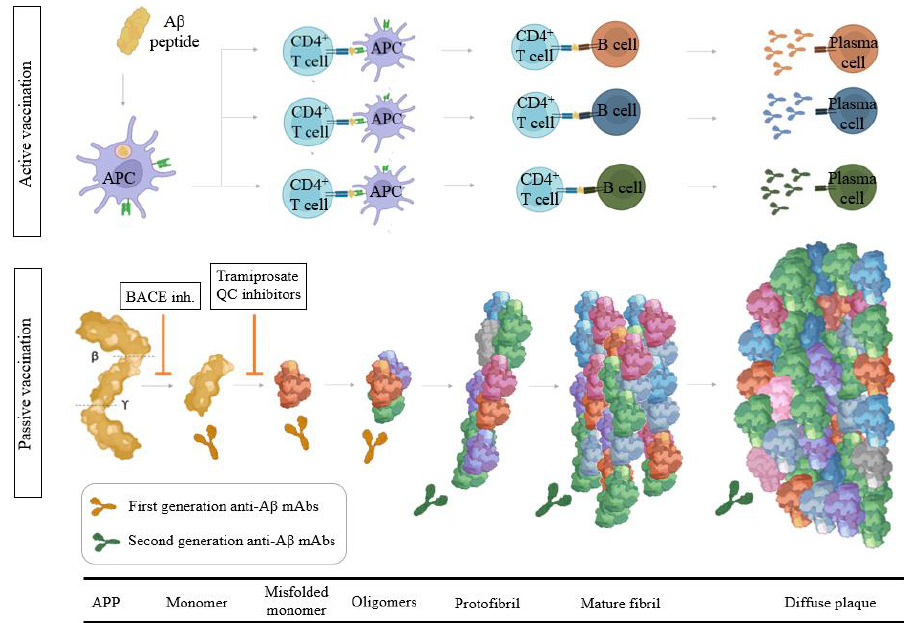
Figure 1. Anti- Aβ protei n strategies for the development of DMT. Both active and passive immu- notherapy are currently under evaluation for reducing amyloid deposition and related progression of cognitive impairment in AD (polyclonal vs monoclonal approach). In parallel, other small mole- cules under study target Aβ upstream preventing Aβ misfolding and the generation of toxic pep- tides.